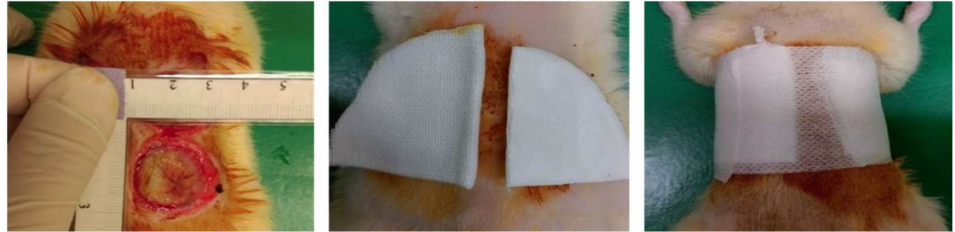
Figure 1. The process of burn injury creation on the rat’s